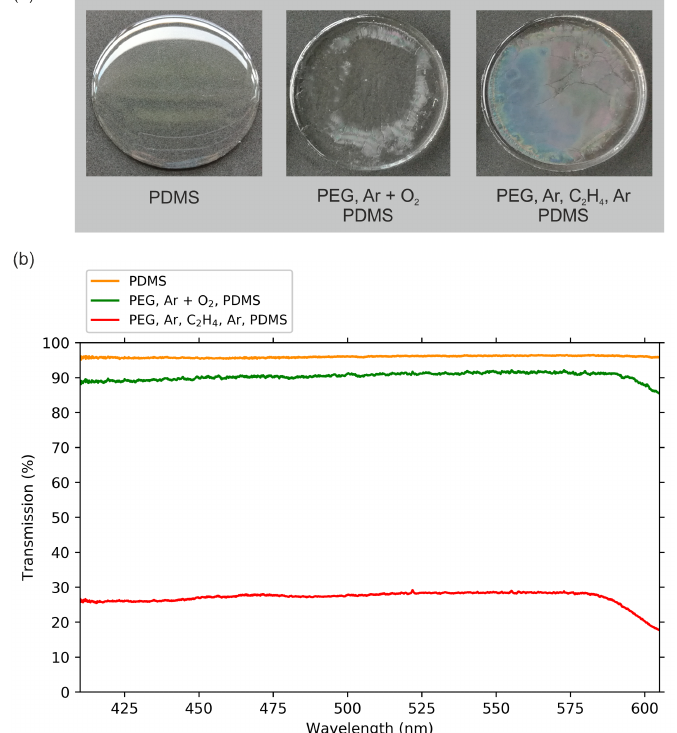
Figure 2. ( a ) Photographs and ( b ) optical transmission spectra of pure PDMS and plasma-treated PEG with PDMS backing. The samples had been lifted off the Petri